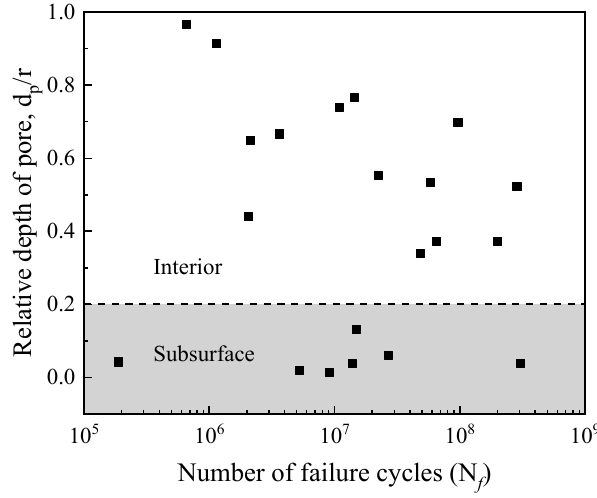
Figure 14. Relationship between relative depths of the pores and fatigue life.